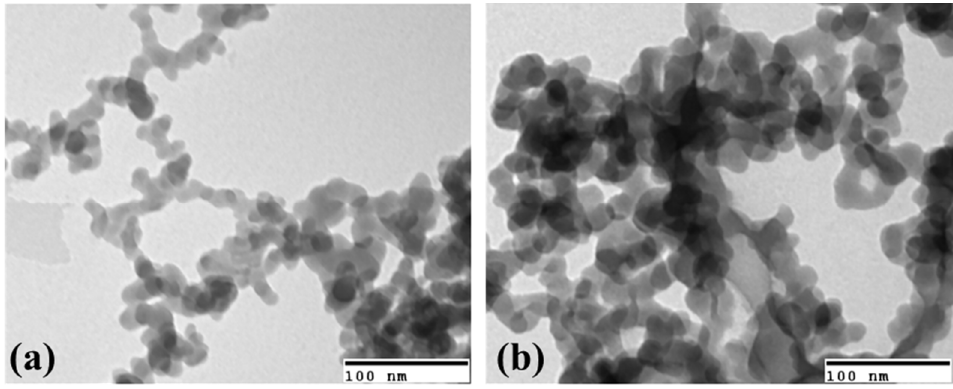
Figure 5. TEM images of additives (130 k magnification). ( a ) The commercial nano silica before